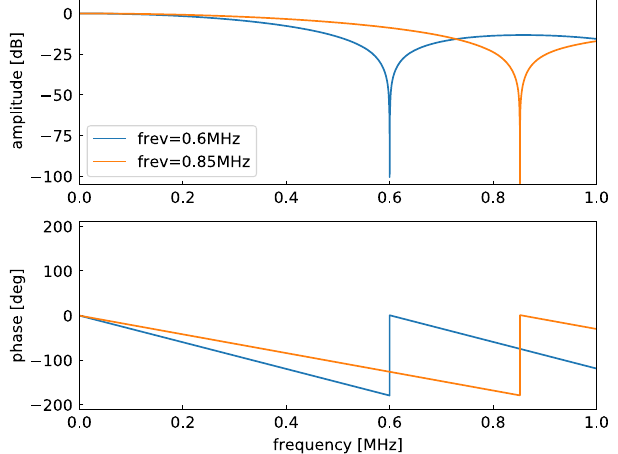
FIG. 9. Amplitude and phase responses of the tracking CIC ¼ 600 and 850 kHz. filter for f rev